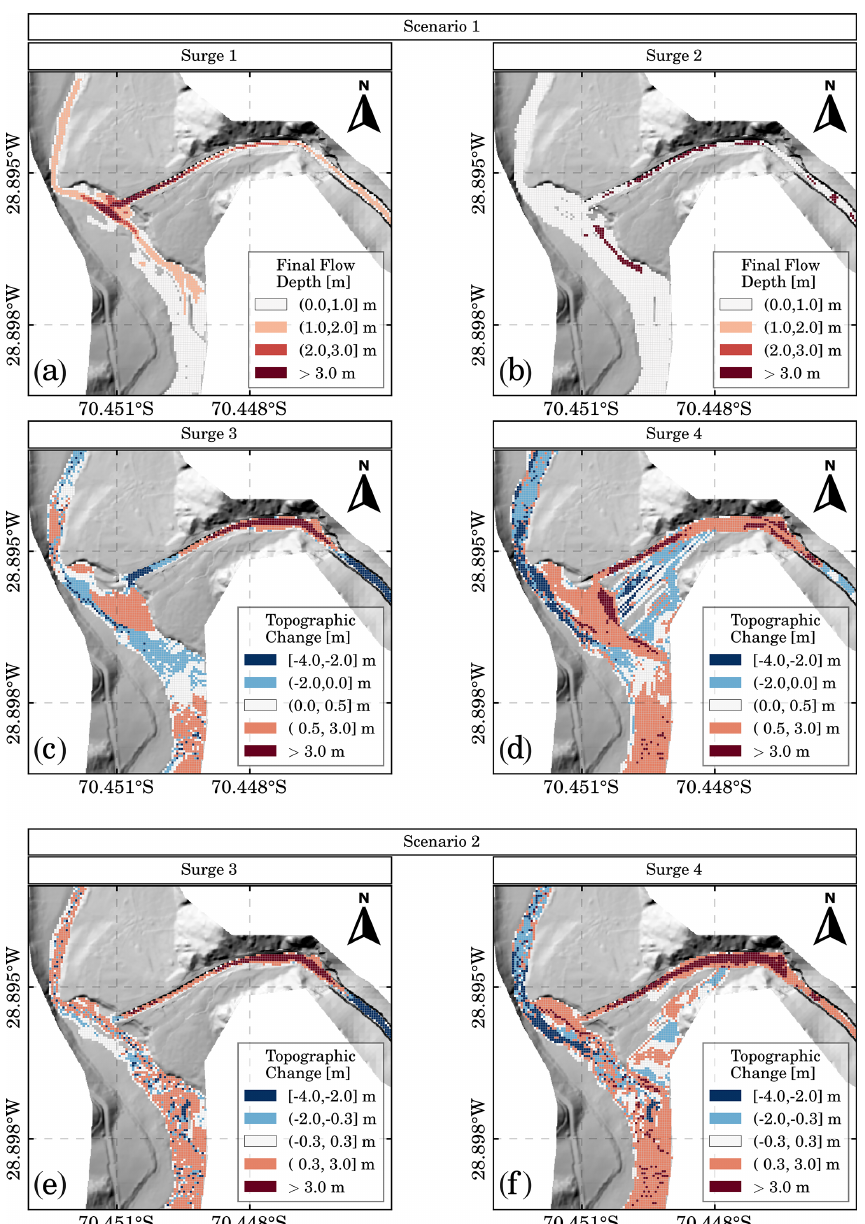
Figure 8. Two future scenarios are modeled to understand the possible effects of a channel (mitigation works): first scenario (a–d) and second scenario (e, f)